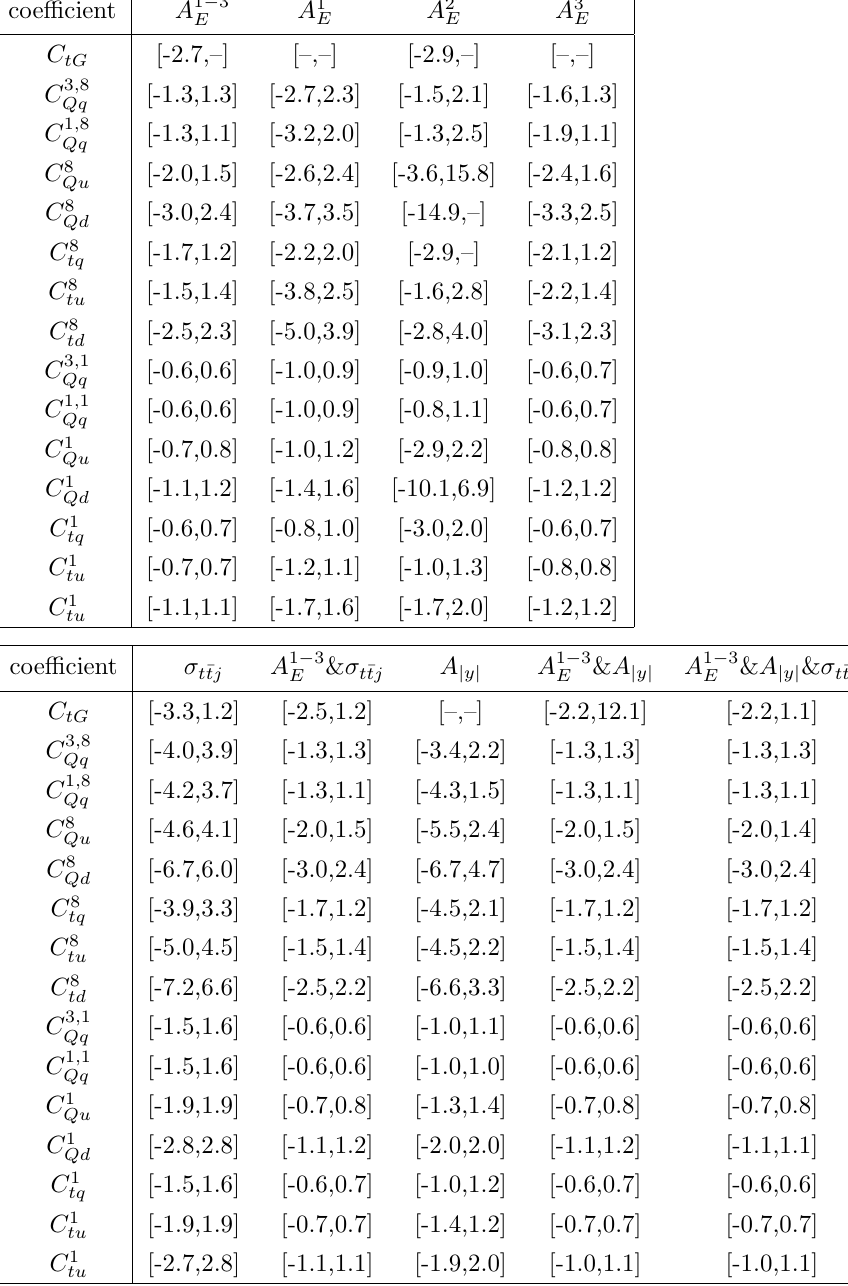
, A 2 , A 3 , their combination A 1 (cid:0) 3 , and the E E E E in t (cid:22) t production j y j